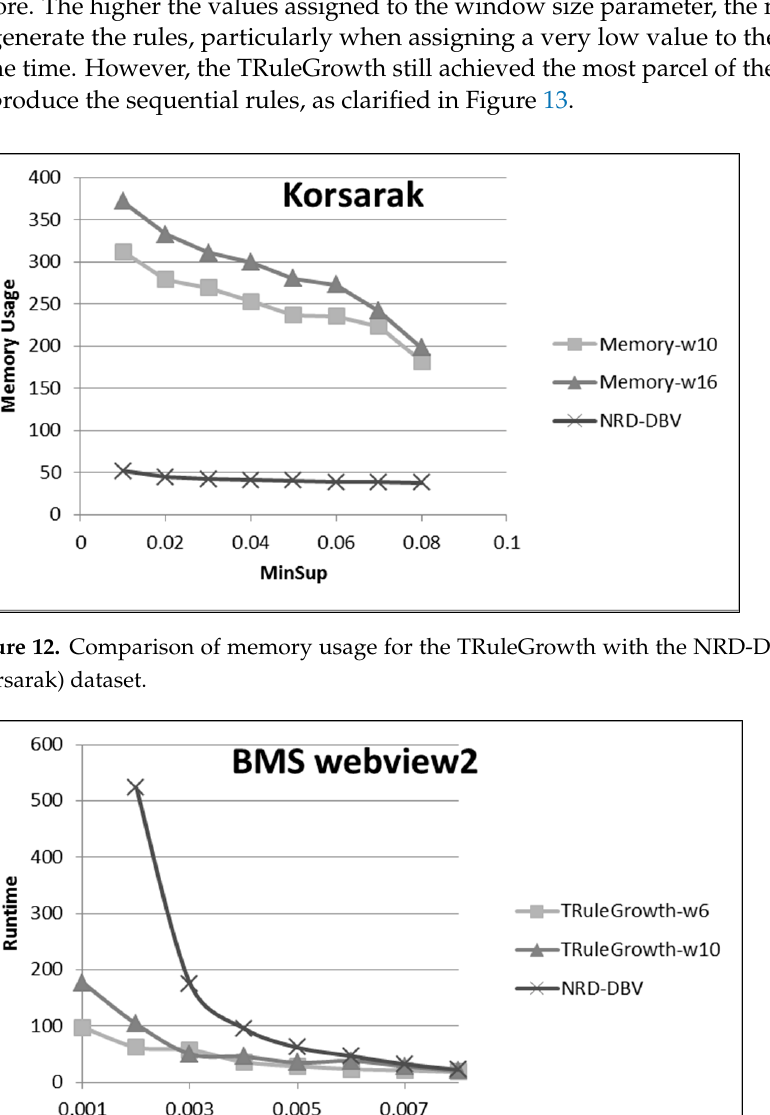
Figure 13. Comparison of the runtime of the TRuleGrowth with the NRD-DBV for (BMS webview2) dataset.